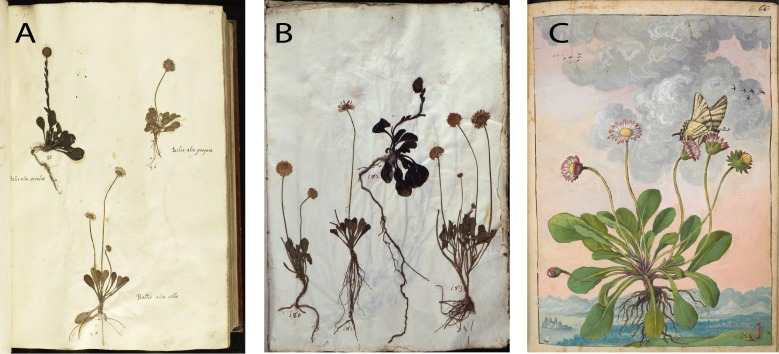
En Tibi (A) vs. Rome herbarium (B), and Cibo painting (C). See also S4 Appendix.